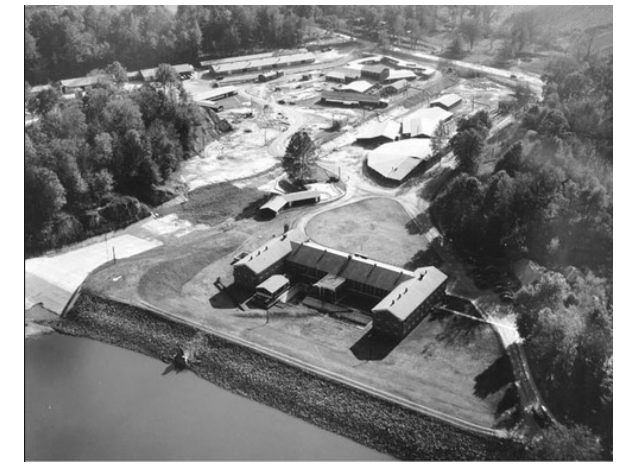
Figure 4. Aerial view of the new WES facilities, 1936.